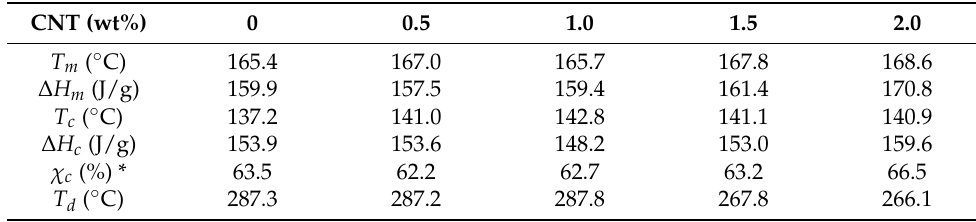
Figure 2. Thermal properties of pristine POM and POM/CNT composites with different CNT con- tents: ( a ) DSC heating; ( b ) DSC cooling traces; ( c ) TGA thermograms. Table 1. Thermal properties of POM/CNT composites with different CNT